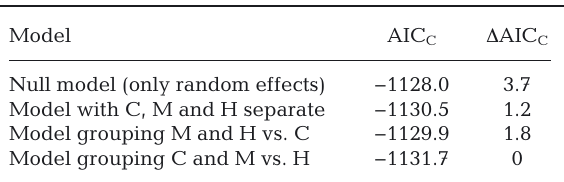
Table 2. Model performance for mixed effect models to eval- uate the effect of holothurian stocking density on seagrass growth for Sites A and B only ( Thalassia hemprichii ). Dif - ferences in Akaike’s information criterion corrected for small sample size ( Δ AIC C ) values are given relative to the best-performing model, which itself has a Δ AIC C value of 0 (p < 0.05). C: control (no Holothuria scabra ); M: medium stocking density; H: high stocking